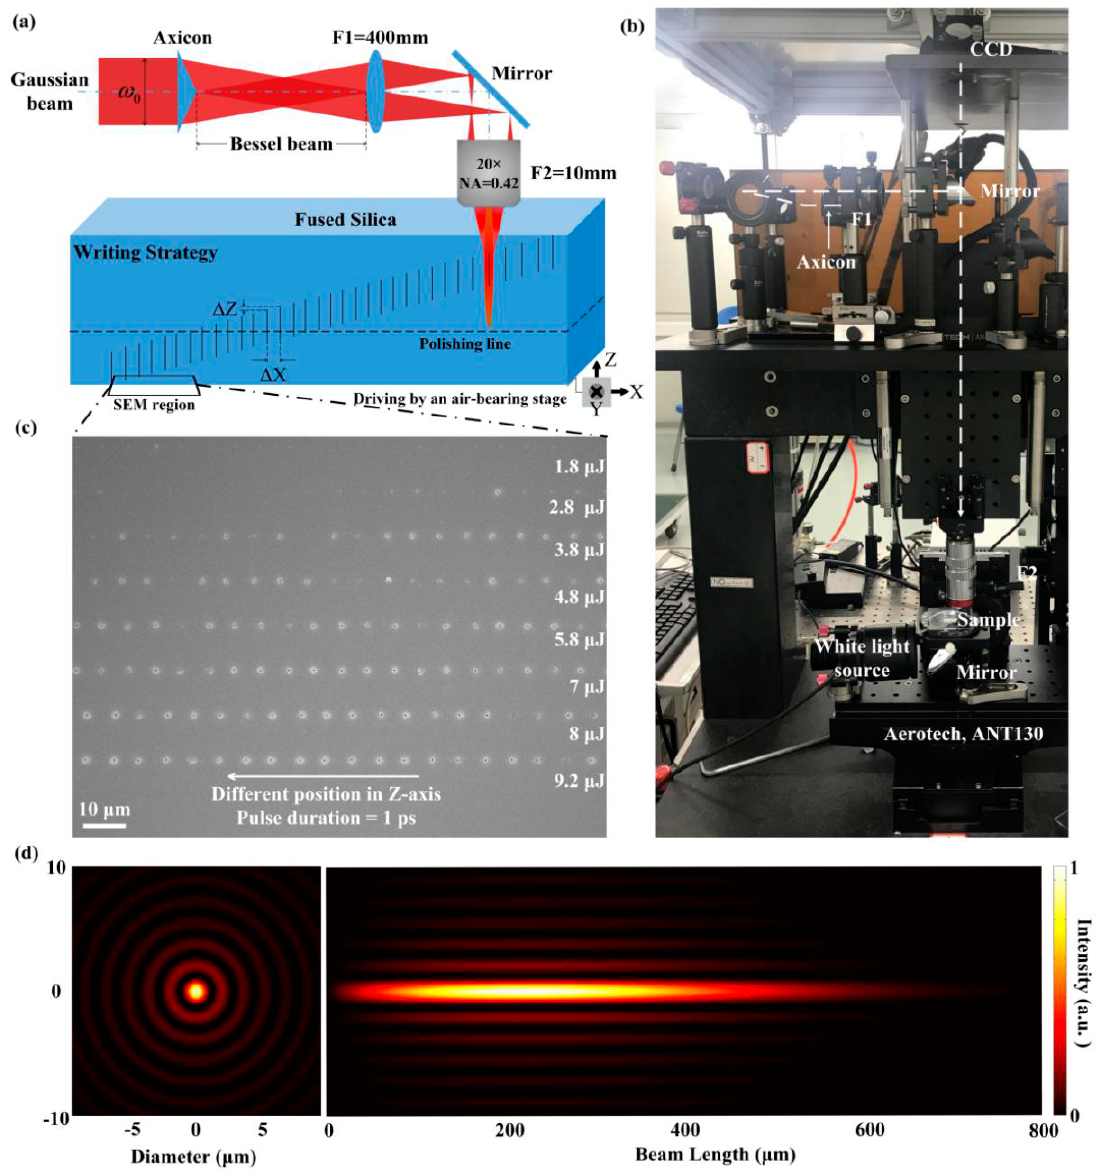
Figure 1. ( a ) Schematic setup for generating the tomography of high-aspect-ratio nano-hole. The dashed line indicates the polishing plane where the cross-section of nanohole is checked with SEM. ( b ) Setup of the Gaussian-Bessel pulse beam processing system. ( c ) Nano-holes array induced on the bottom surface of the fused silica which was revealed by SEM before polishing procedure. ( d ) Simulated linear intensity profiles of the Bessel beam inside the fused silica on axial and radial sections.